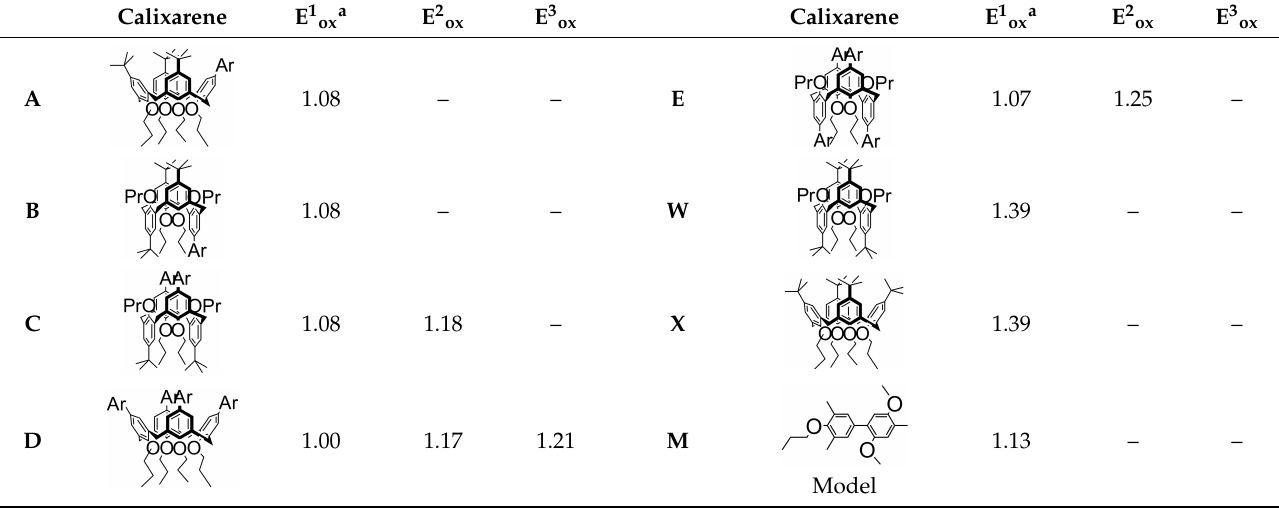
Table 1. Electrochemical oxidation potentials of various calixarenes to their cation radicals.